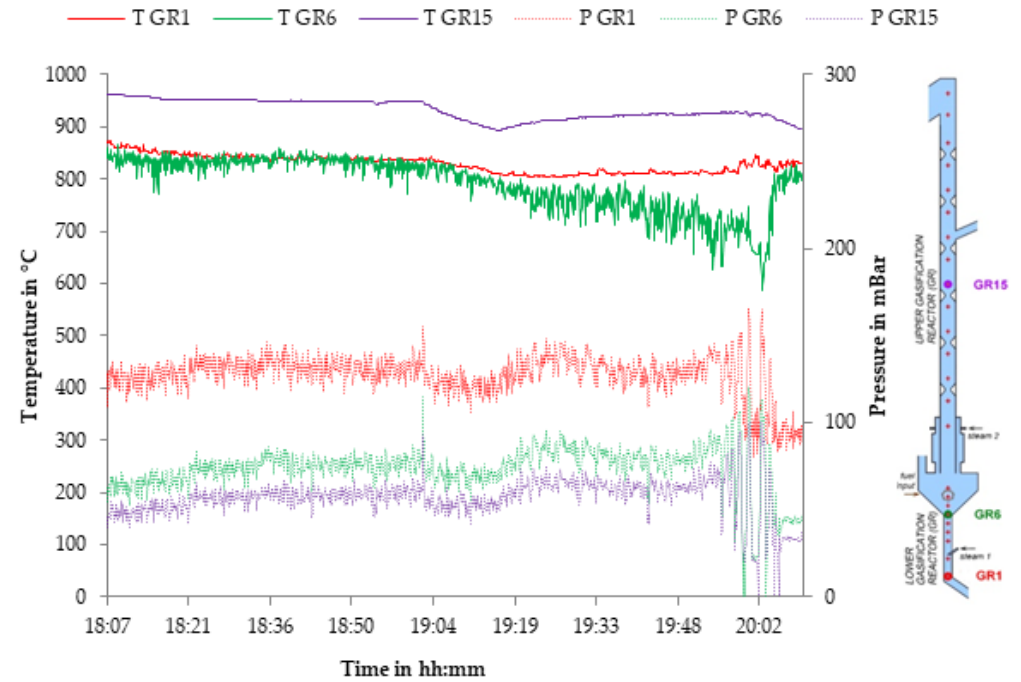
Figure 3. Left: Temperature and pressure measurement of gasification reactor at measurement points GR1, GR6 and GR15. Right: scheme of gasification reactor with the measurement points [23].